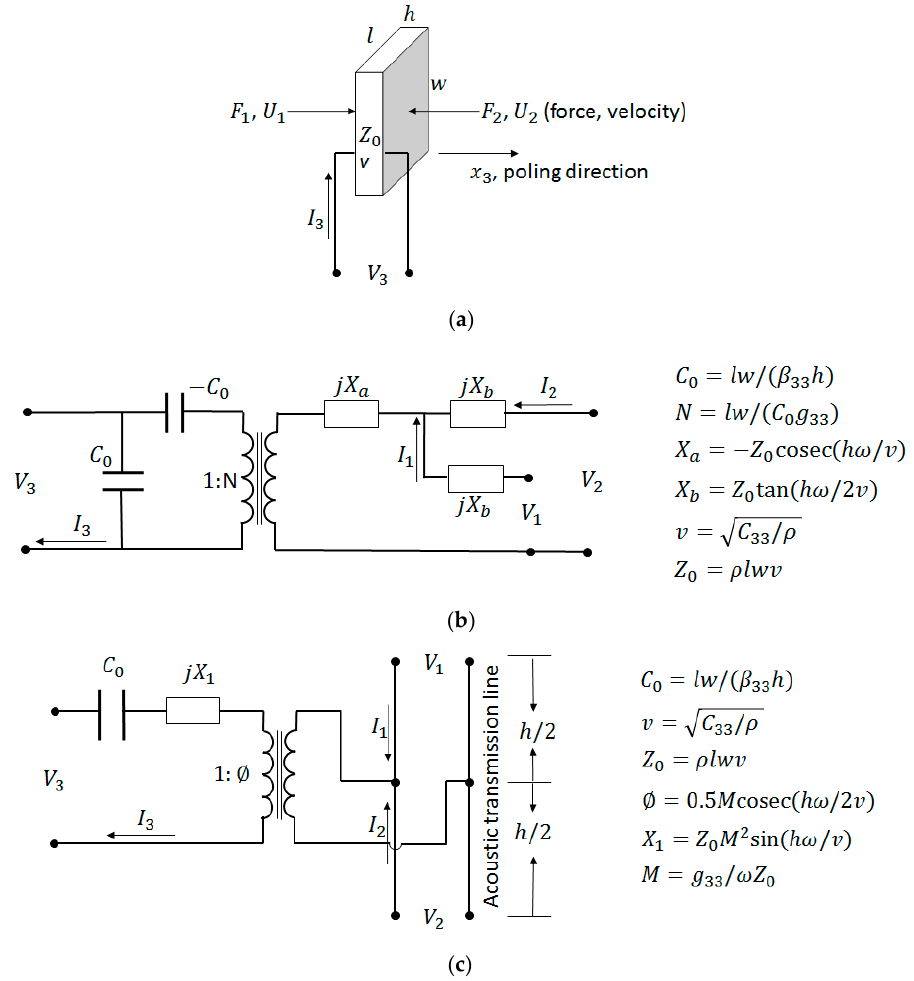
Figure 6. ( a ) Schematic of a piezoelectric wafer operating in the thickness mode with its geometry showing the poling direction, voltage across electrodes V 3 and direction of forcing ( F 1 , F 2 ), and velocity ( U 1 , U 2 ). ( b ) Mason’s electric equivalent circuit. ( c ) Krimholtz, Leedom, and Matthaei (KLM) electric equivalent circuit. Here, 𝜌 = density, 𝜔 = angular frequency, 𝛽 = dielectric impermeability,